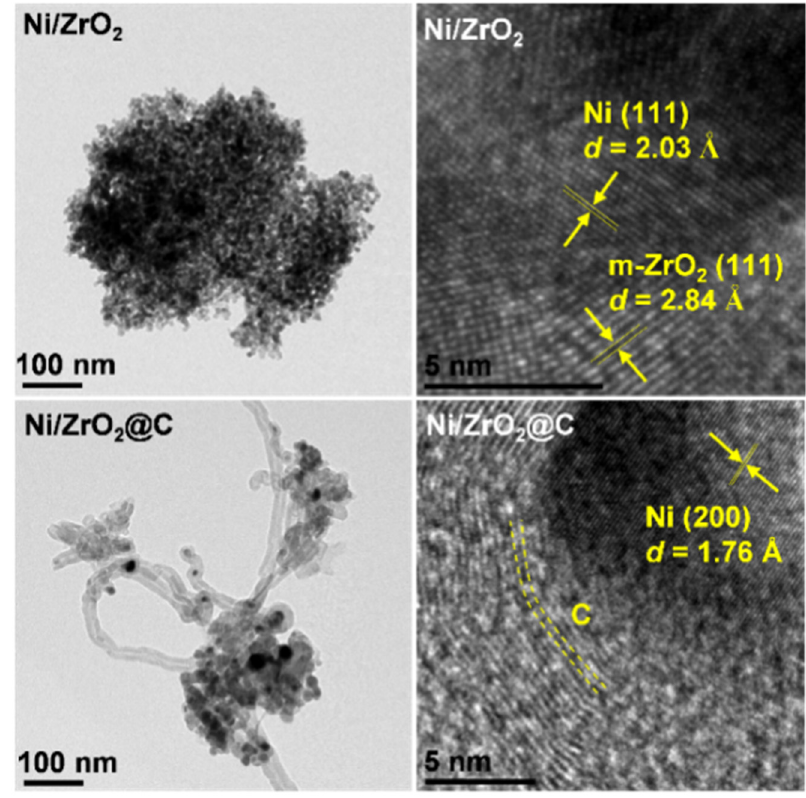
Figure 4. TEM images of Ni/ZrO 2 and Ni/ZrO 2 @C.